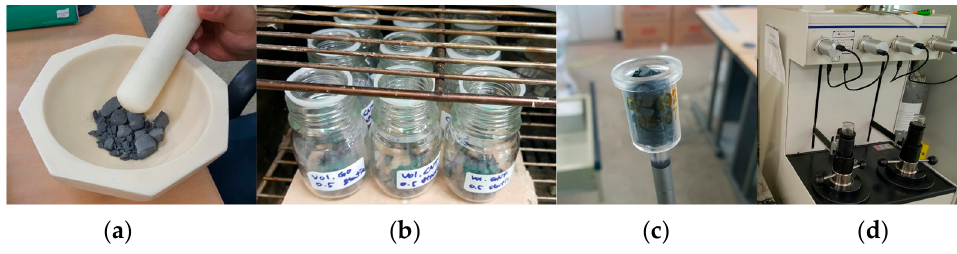
Figure 4. Mercury Intrusion Porosimetry (MIP) test; ( a ) fragments of crushed specimens; ( b ) fragments immersed in acetone; ( c ) fragments after drying; and ( d ) injection Mercury to measure pore volume.